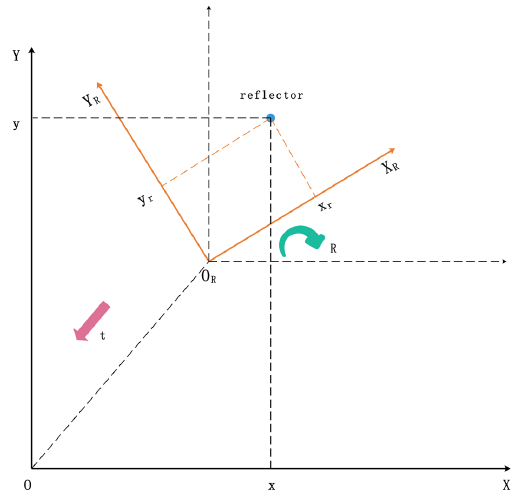
Figure 6. Rotation vector R and translation vector t.